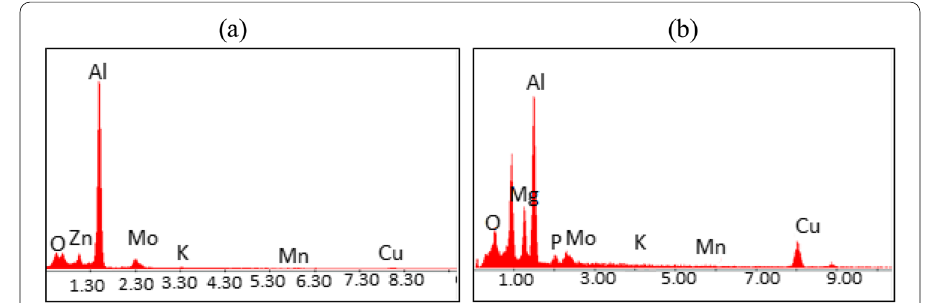
Fig. 6 EDS analysis of the surface of the alloy after treatment with a S3 and b S4